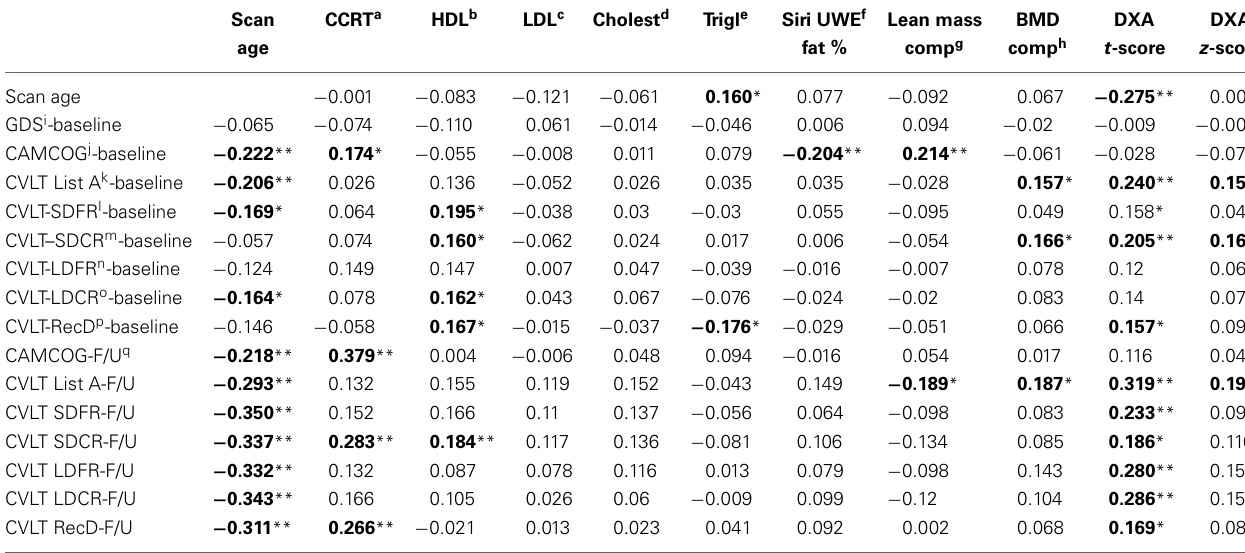
Table 3 | Associations between Dual-energy X-ray absorptiometry (DXA), baseline, and follow up cognitive measures